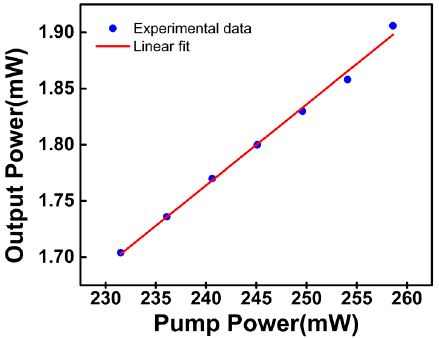
Figure 4. The output power as a function of pump power.